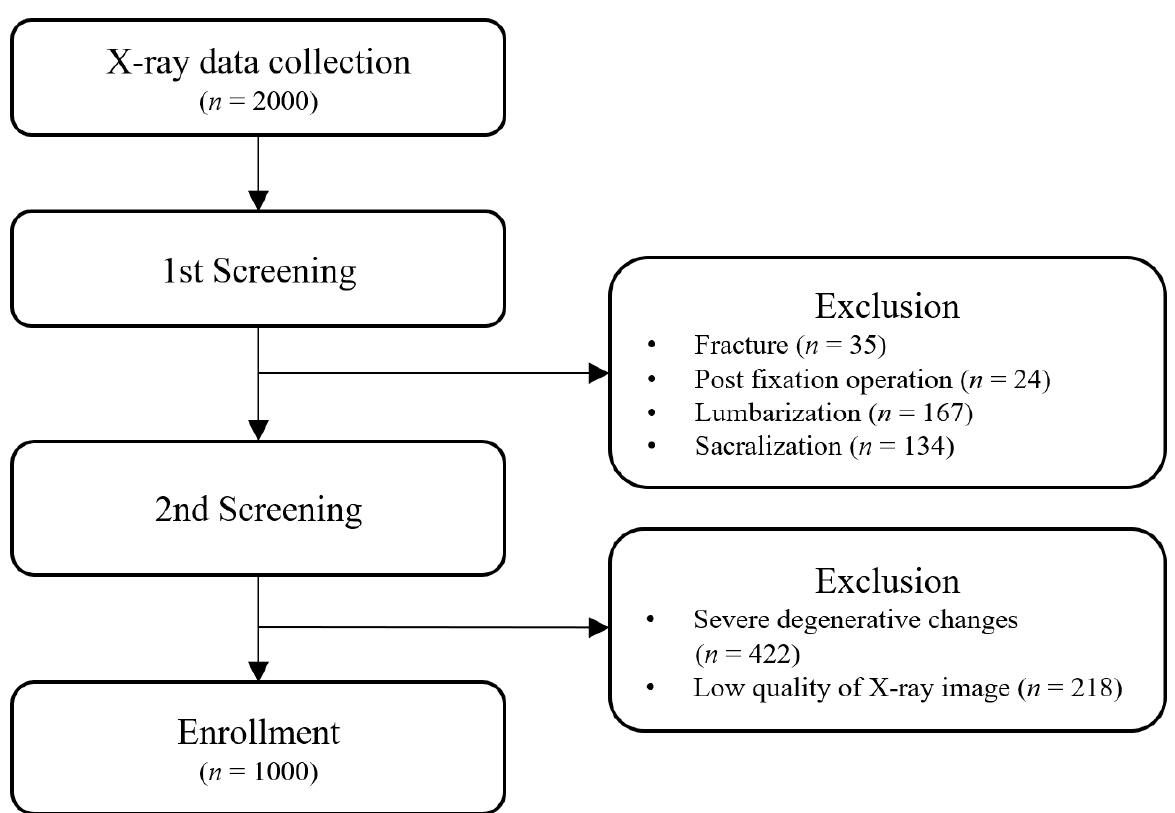
Figure 1. Flow diagram indicating detailed exclusion steps .